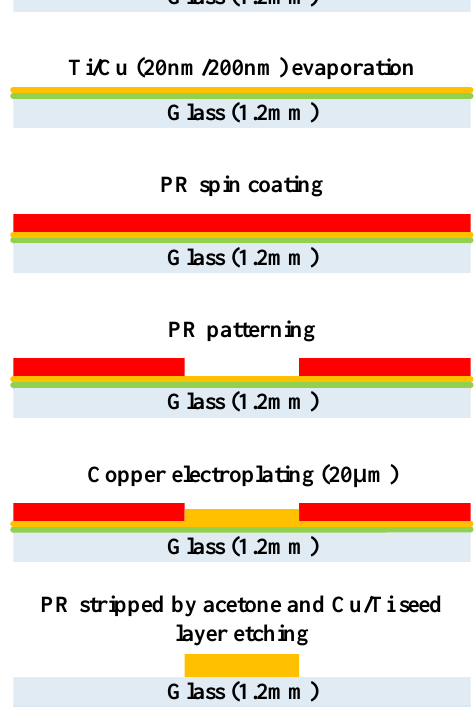
Figure 2. Fabrication process for creating a single layer transparent atom chip without heat dissipation design.